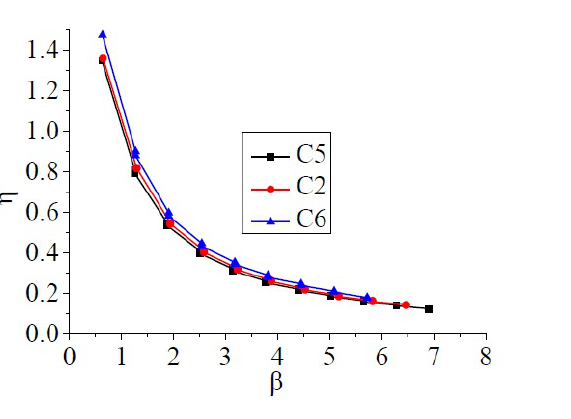
and 38.04%, respectively, compared with that of C6. This finding is observed because the cyclic displacements of C2 and C5 are slightly larger than that of C6. Therefore, in- creasing the stirrup ratio of a TRC strengthened column can improve the column’s deformation capacity and seis- mic behaviour. Except for when the accumulated energy dissipation curves of C2 and C6 at the later stage of dis- placement loading are different, the energy dissipation curves at other stages are largely coincident; this finding indicates that the reduction of the stirrup ratio has little in- fluence on the energy dissipation capacity of the strength- ened column within a certain range of stirrup ratios.